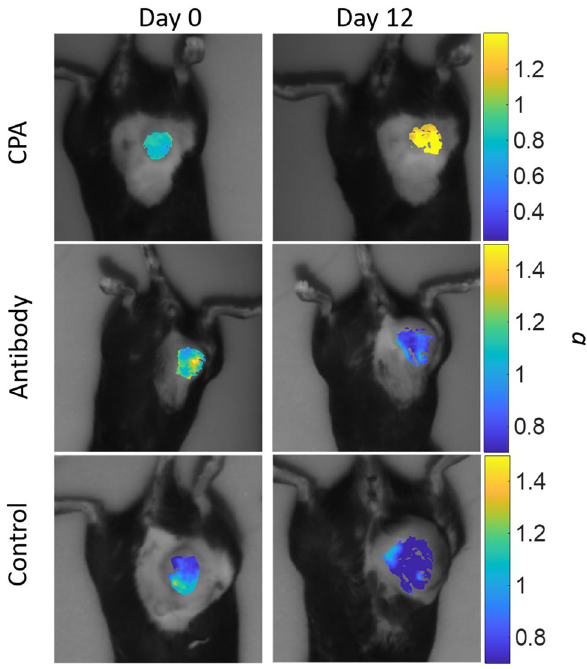
Figure 3. SFDI maps across treatment groups. Representative wide-field SFDI maps of the changes in a parameter (mm −1 ) at Day 0 and 12 across the each of the three treatment